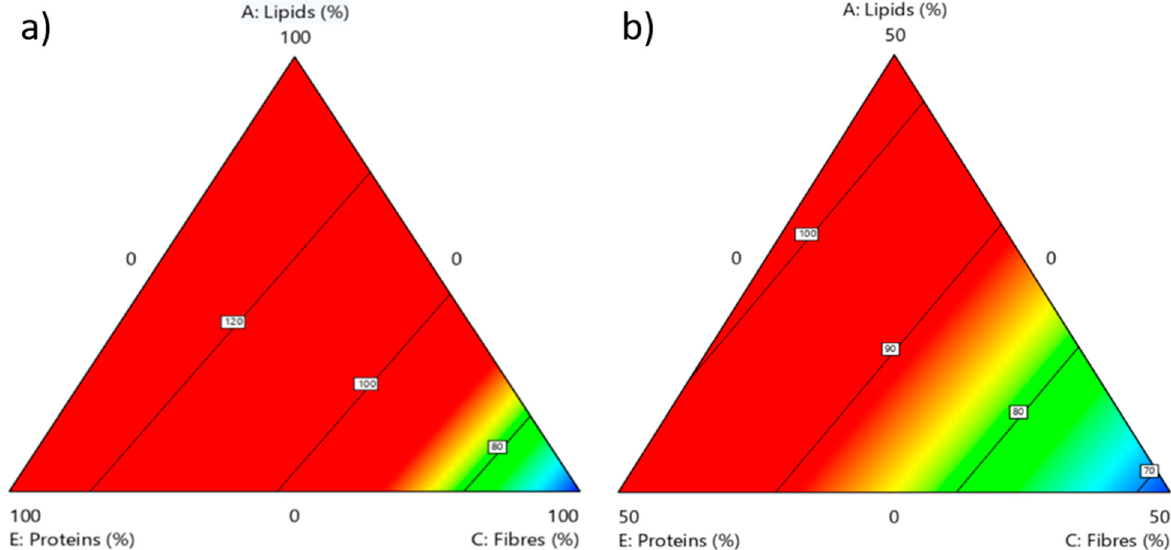
Figure 5. Graphical model variation of the amount of leucine in the proteins of BSF prepupae in relation to the composition of the rearing substrate in terms of lipids, proteins and fibres, considering two scenarios: ( a ) carbohydrates = 0 wt%; ( b ) carbohydrates = 50 wt%. The region representing the highest value of the response is shown in red colour whereas the lowest values are in blue. For each response, the most significant factor has been considered for the graphical model, expecting a higher variation in the response behaviour.